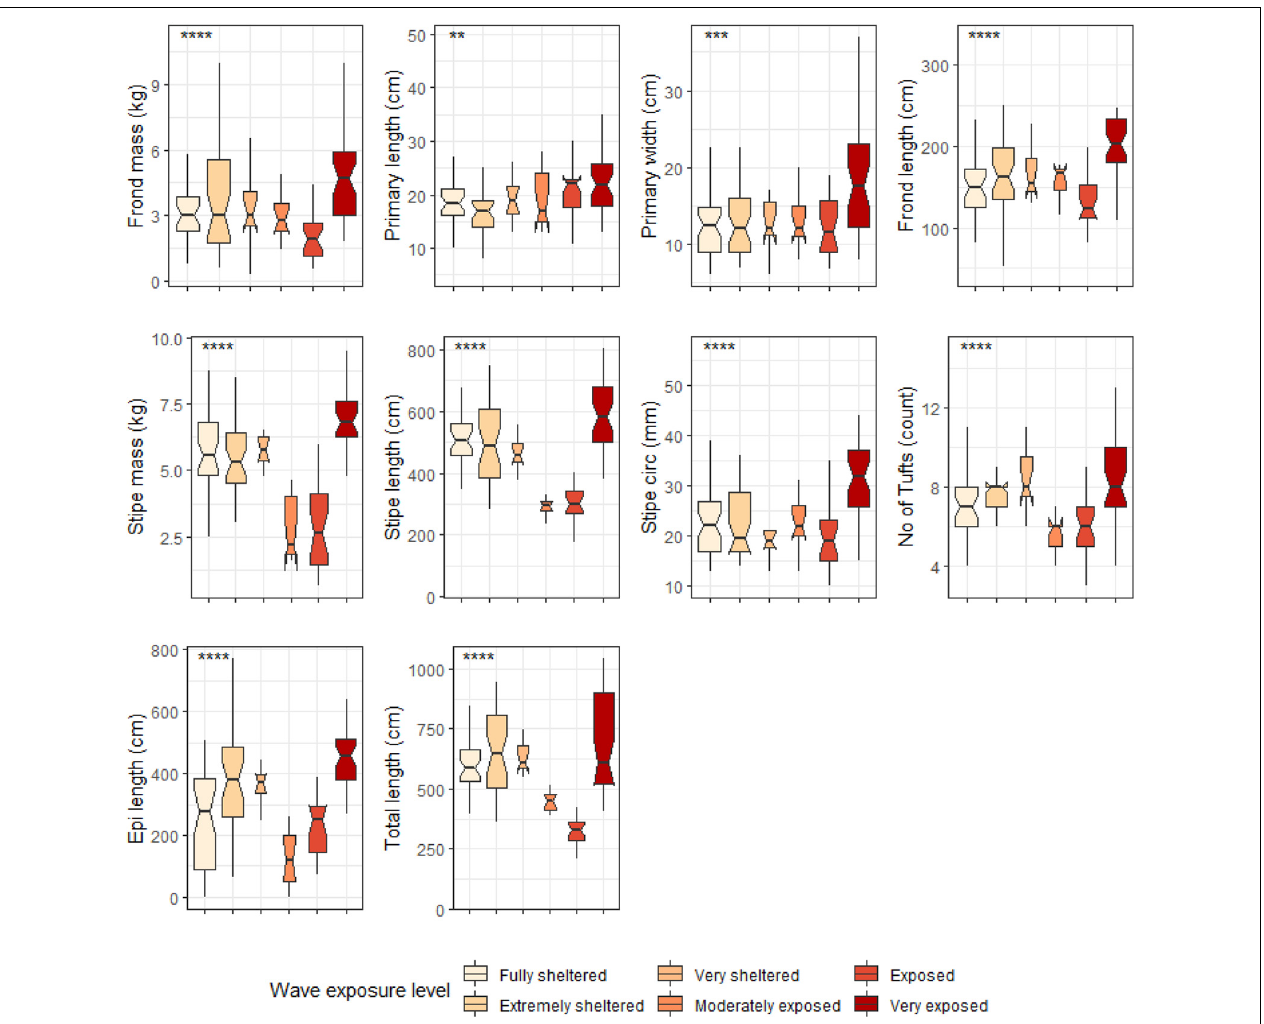
FIGURE 9 | Boxplots representing deep E. maxima morphological characteristics grouped by wave exposure category measured around the Western Cape coastline, with the y -axis depicting the specific morphology measured, with units provided. The lower and upper hinges correspond to the first and third quartiles. The whiskers represent the range, solid black lines represent the median and black dots are outliers. Significance levels are as follows: * represents ≤ 0.05, ** represents ≤ 0.01, *** represents ≤ 0.001, **** represents ≤